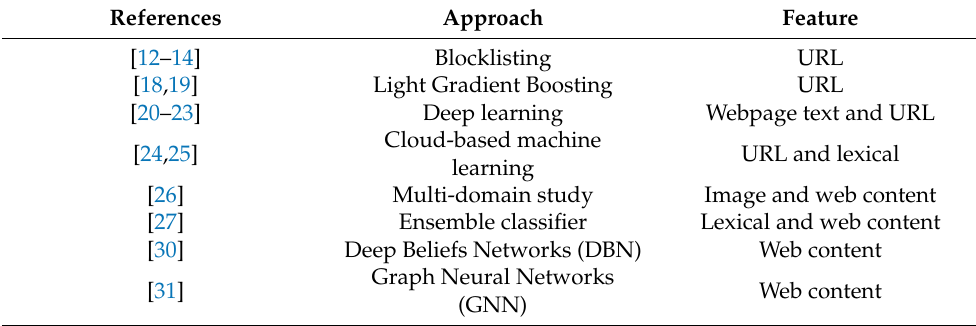
Table 1. Summary of some related